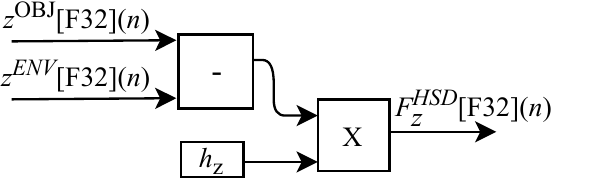
Figure 31. Proposed circuit to calculate the feedback force F HSD z [ F 32 ]( n ) (Equation